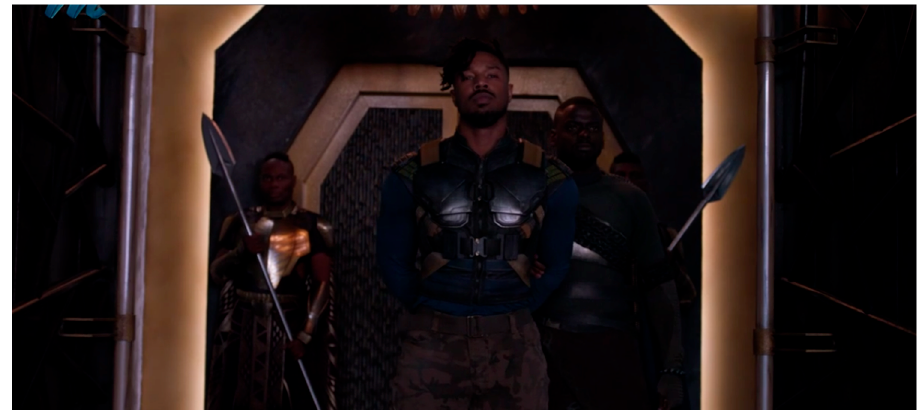
Figure 2. Eric Killmonger presented to council in Wakanda (Taken in accordance with fair use of images rights for the film Black Panther , Ryan Coogler, 2018, Marvel).